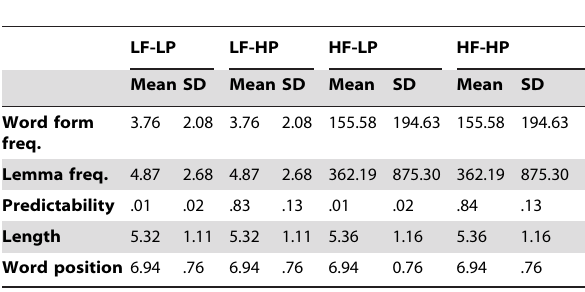
Table 1. Descriptive statistics of target